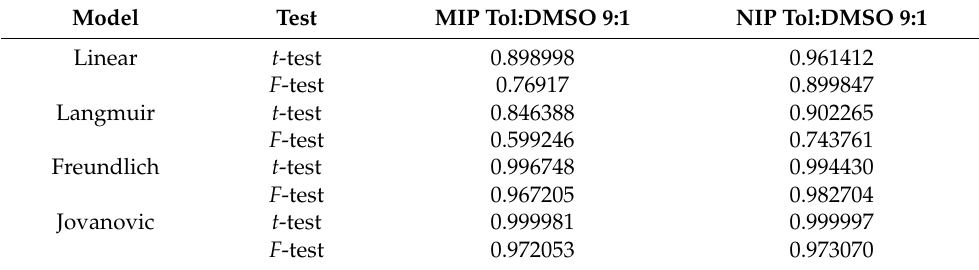
Table 6. Isotherm error deviation estimation related to the adsorption of atrazine using alternative statistical tools.